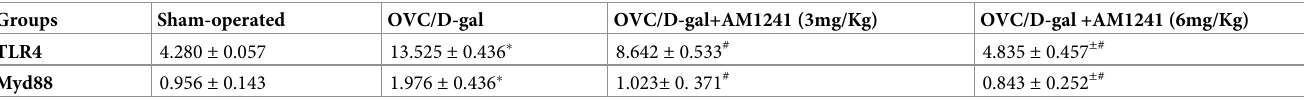
Values expressed as mean ± SE. � , #, and ± statistically significantly different at P < 0.05, where; � statistically significant difference comparing with the control group, # statistically significant difference comparing with OVC/D-gal group, ± statistically significant difference comparing with AM1241